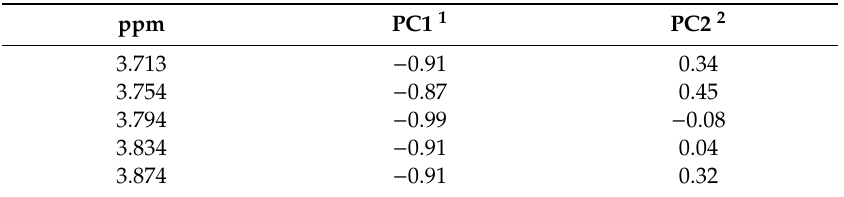
Table 5. Most correlated un-assigned bins of swine colostrum obtained from the principal component analysis carried out on the un-assigned binned